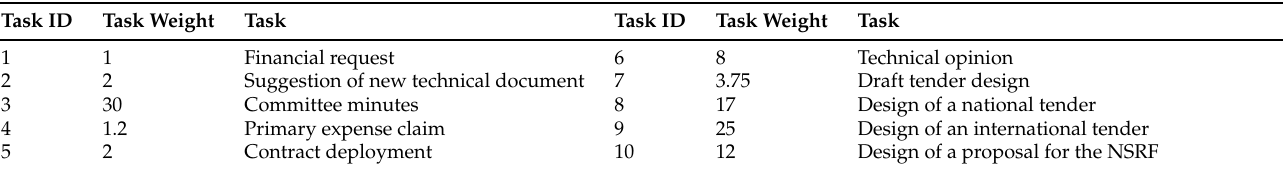
Table 3. Relationship